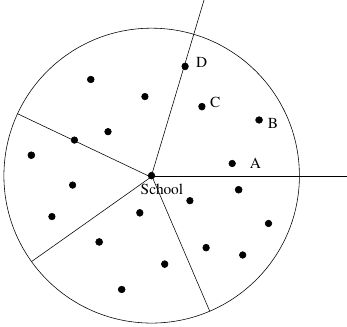
Figure 5. Site grouping strategy. (The dots represents transfer stations, and the stations in the fan-shaped area formed by two adjacent letters are a group.)